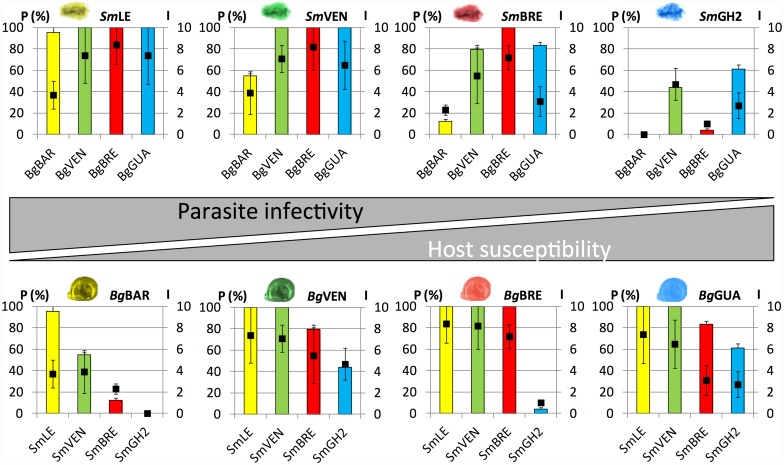
Compatibility trials between different strains of parasites and snails.Each pairwise combination of the studied strains of schistosomes (SmLE, SmVEN, SmBRE, and SmGH2) and snails (BgBAR, BgVEN, BgBRE, and BgGUA) were tested for compatibility. The upper graphs present the prevalence (P in %) and intensity (I) of infection for each S. mansoni in the different B. glabrata host strains. The lower graphs present the prevalence and intensity of infection for each B. glabrata strain when confronted by the four S. mansoni strains. Prevalence values are represented by colored histograms, while intensity values are indicated by black squares. The sympatric snails and schistosomes bear the same color. The presented data represent the mean values obtained for three independent experiments, the data obtained by (Theron et al, 2014) and two other experiments performed in 2010 and 2012. Error bars represent the average absolute deviation of the mean.